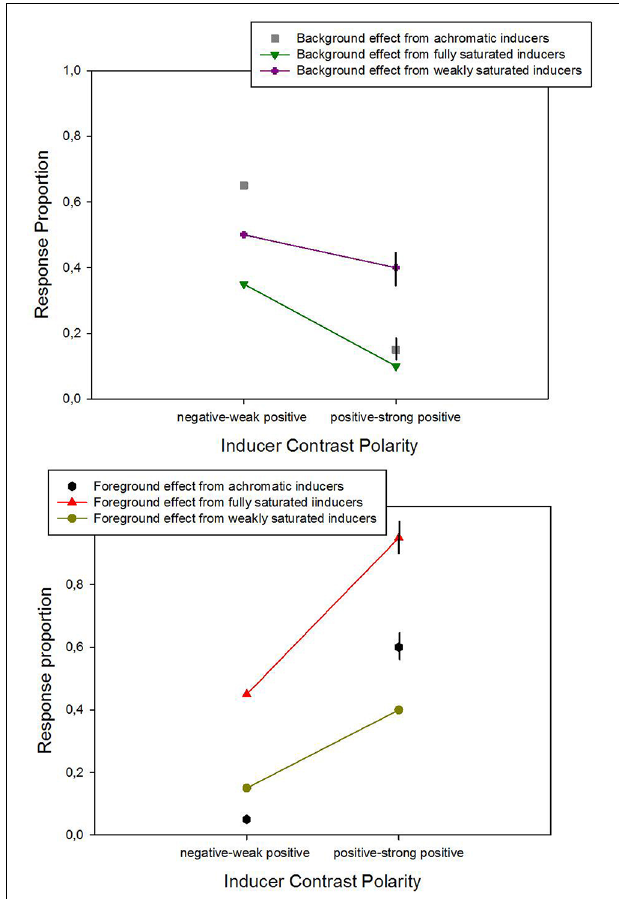
FIGURE 9 | Average response proportions for background (upper panel) and foreground effects (lower panel) as a function of the two contrast polarity categories (analysis 4). 2 × 2 ANOVA signaled statistically significant effects of contrast polarity on background (top) and foreground (bottom) effects. Post-hoc paired comparisons between individual means from achromatic inducer-background configurations and data from configurations with color on gray signaled a significant difference between achromatic and weakly saturated inducers for background effects in the positive contrast polarity range (top, with error bars for the two conditions of that comparison), and a significant difference between achromatic and fully saturated inducers for foreground effects (bottom, with error bars for the two conditions relative to that